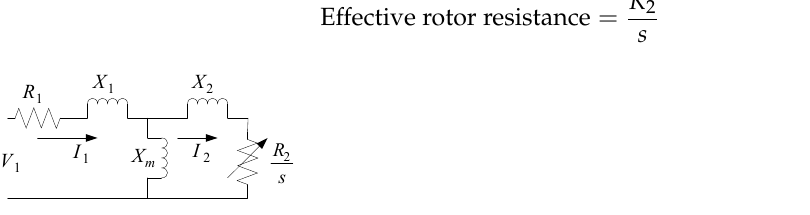
Figure A1. Equivalent circuit of an induction generator.